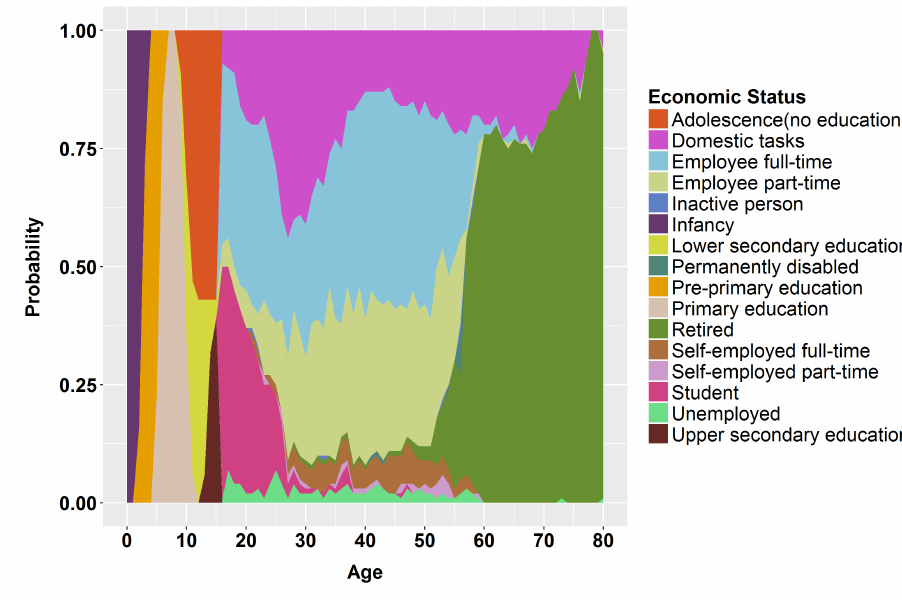
Figure 1. Life course trajectory of a German, female, retired, age of 80 in